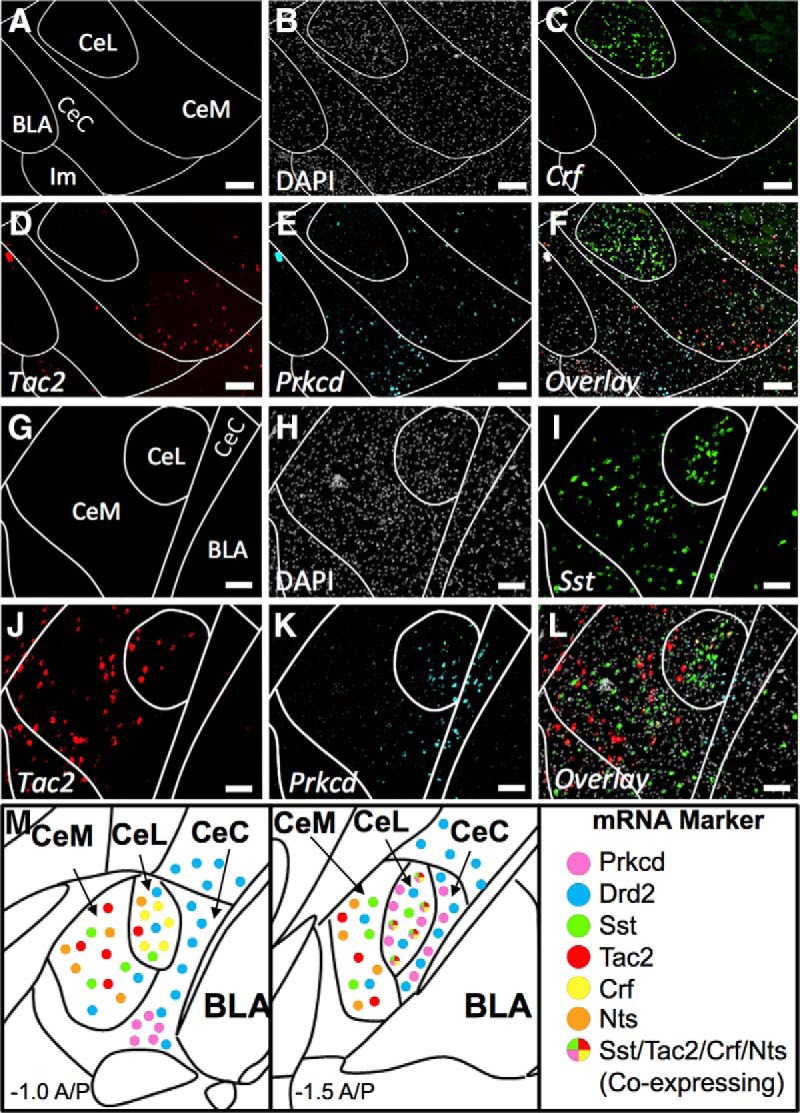
Coexpression of Crf, Tac2, and Prkcd; and Sst, Tac2, and Prkcd (A-P -0.8 and -1.22). A, Map of area examined (A-P ∼-0.8). B, DAPI stain (gray) of area examined. C, Crf expression (green) is found strongly in CeL. D, Tac2 expression (red) is found in the CeM. E, Prkcd expression (cyan) is found strongly in ventral CeC. F, Overlay of B–E reveals limited overlap in expression of any marker examined. Scale bar: 200 µm. G, Map of area examined (A-P ∼-1.2). H, DAPI stain (gray) of area examined. I, Sst expression (green) is found strongly in CeL and CeM. J, Tac2 expression (red) is found in the CeL and CeM. K, Prkcd expression (cyan) is found strongly in CeL and CeC with limited expression in the CeM. L, Overlay of H–K reveals limited overlap in expression of any marker examined. Scale bar: 50 µm. M, Summary figure demonstrating localization and colocalization of examined CeA mRNA markers.